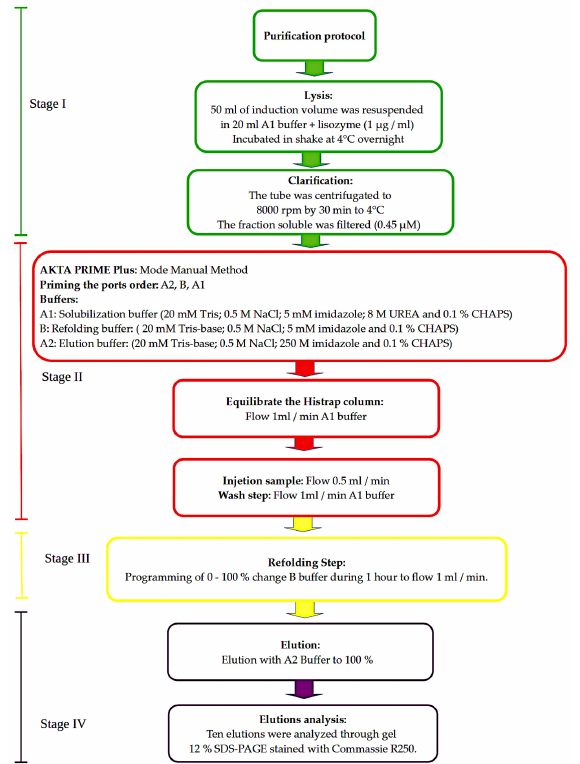
Figure 1. Purification protocol of LHR-Bed. The figure summarizes the four stages of the purification protocol. Stage I (green): lysis and fraction-obtaining. Stage II (red): Akta Prime preparation in manual mode. Stage III (yellow): refolding. Stage IV (purple): elution analysis.